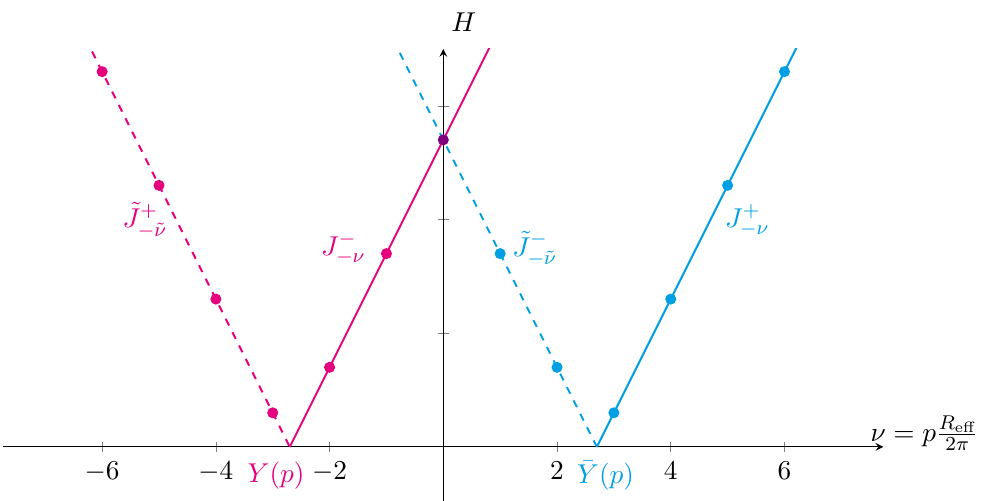
Figure 3 . Some excitations in the (cid:13)owed sector with w = 2. We plot in red the dispersion H ( p ) for the excitation Y ( p ), and in cyan the one for (cid:22) Y ( p ). The position of the cusp where kp = (cid:0) (cid:22)R e(cid:11) is between (cid:0) 3 and (cid:0) 2, or between 2 and 3. We highlight the allowed mode numbers with dots; the mode numbers falling on the positive slopes (solid lines) correspond to chiral excitations J (cid:6) the ones on the negative slopes (dashed lines) correspond to anti-chiral ones, ~ J (cid:6) mode-number is shifted with respect to (cid:12)gure